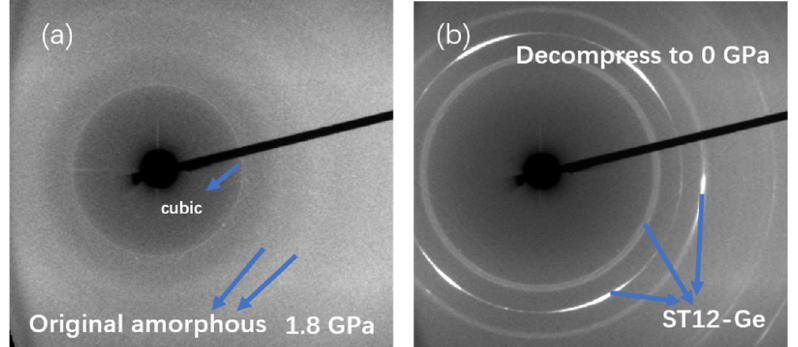
Figure 1. Two-dimensional XRD patterns of amorphous Ge under hydrostatic pressure in ( a ) and high-pressure quenched phase in ( b ). A ST12-Ge phase can be obtained under decompressing to ambient condition.